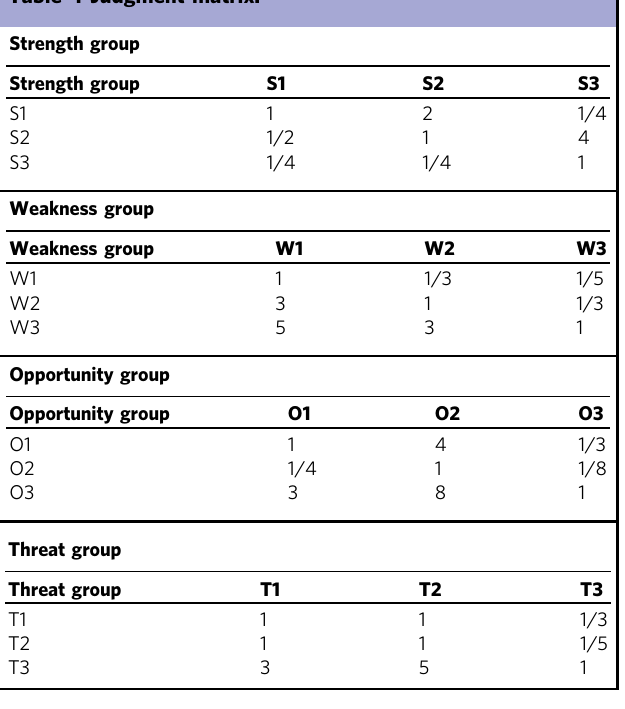
Cross-group ranking of SWOT factors . The cross-group ranking of the SWOT factors is shown in Table 5. Table 4 Judgment matrix.